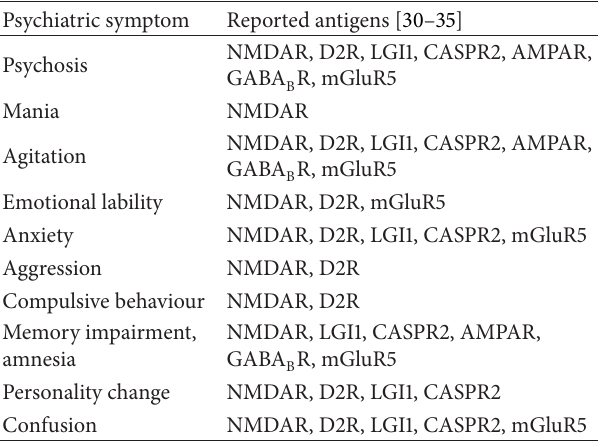
Table 1: Psychiatric symptoms associated with antibodies to cell surface